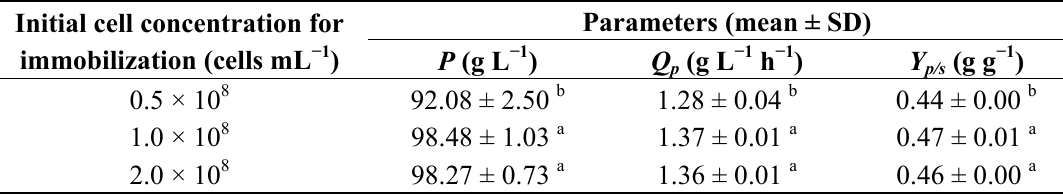
Table 2. Fermentation parameters at 72 h of batch ethanol production from sweet sorghum juice by immobilized yeast. The immobilized yeast cells were prepared at different initial cell concentrations in YM